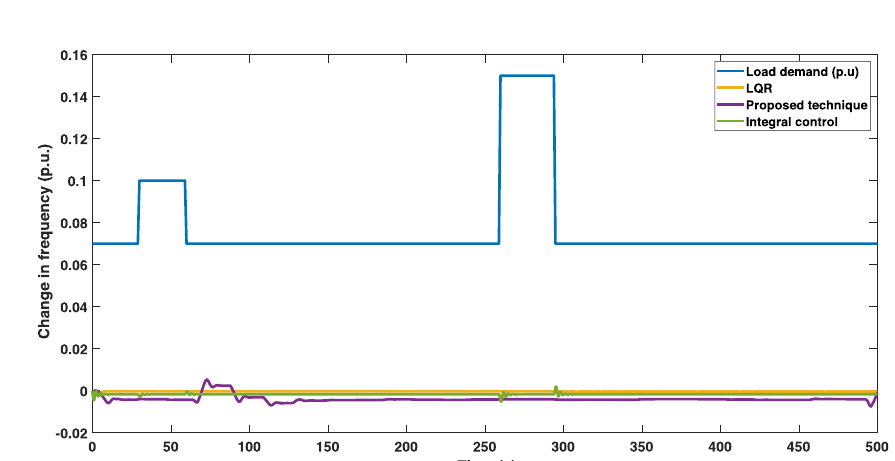
Fig. 7 Comparison of frequency deviation with the application of integral control, LQR and proposed technique for a measurement noise variance of